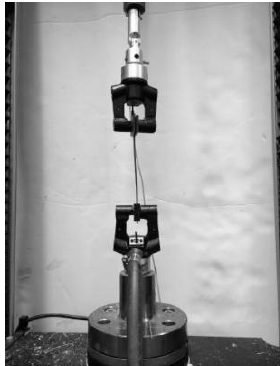
Figure 4. Setup for evaluating tensile properties of rattan strips in this experiment.